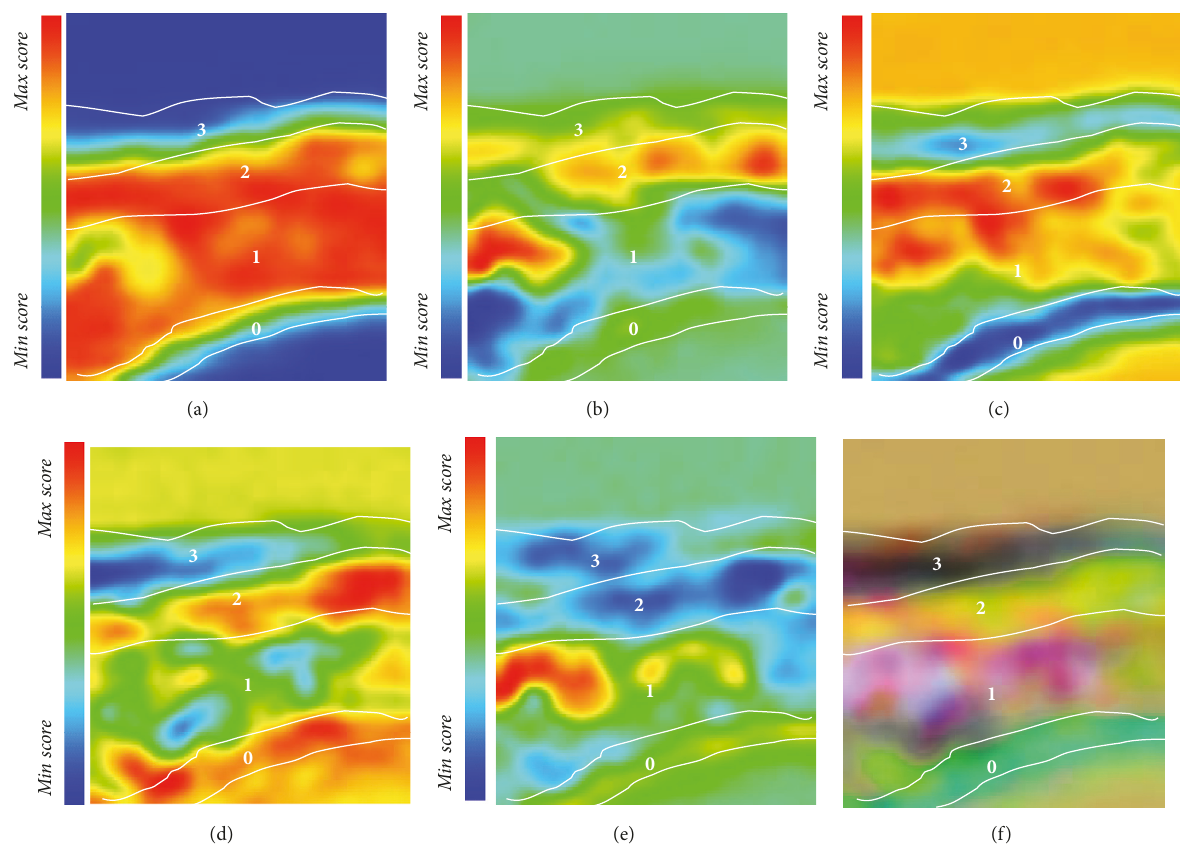
Figure 6: Sample PO1—score maps. (a) PC1, (b) PC2, (c) PC3, (d) PC4, (e) PC5, and (f) PC false colour image (RGB) obtained by coding the PC3, PC4, and PC5 score values as the intensity of the red, green, and blue channels, respectively.